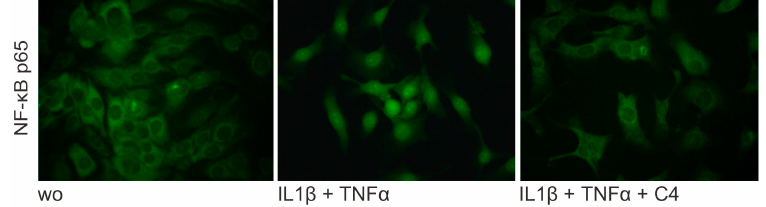
Figure 5. Butyrate suppresses NF- κ B p65 translocation in inflamed HSC-2 cells. Butyrate at 10 mM attenuates the intracellular translocation of NF- κ B p65 into the nucleus, induced by 10 ng / mL IL1 β and TNF α in HSC-2. (wo), without. Representative immunofluorescence at 40x.